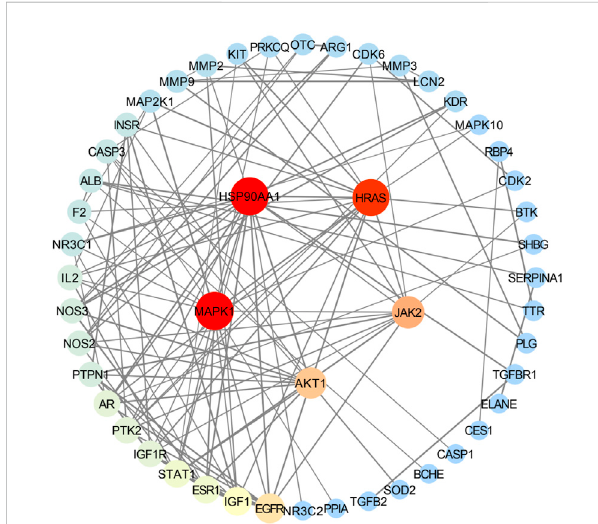
FIGURE 2 Protein – protein interaction (PPI) network diagram of the intersection target of enteritis and thefour active compounds of MCE. Nodesrepresenttargets,andthesizeandcolorareproportionaltothe degree value; the higher the degree value, the larger the node, which is indicated with colors from blue to red. Edges represent the association between targets, and thickness is related to the combination score. The thicker the line, the higher the binding between targets.